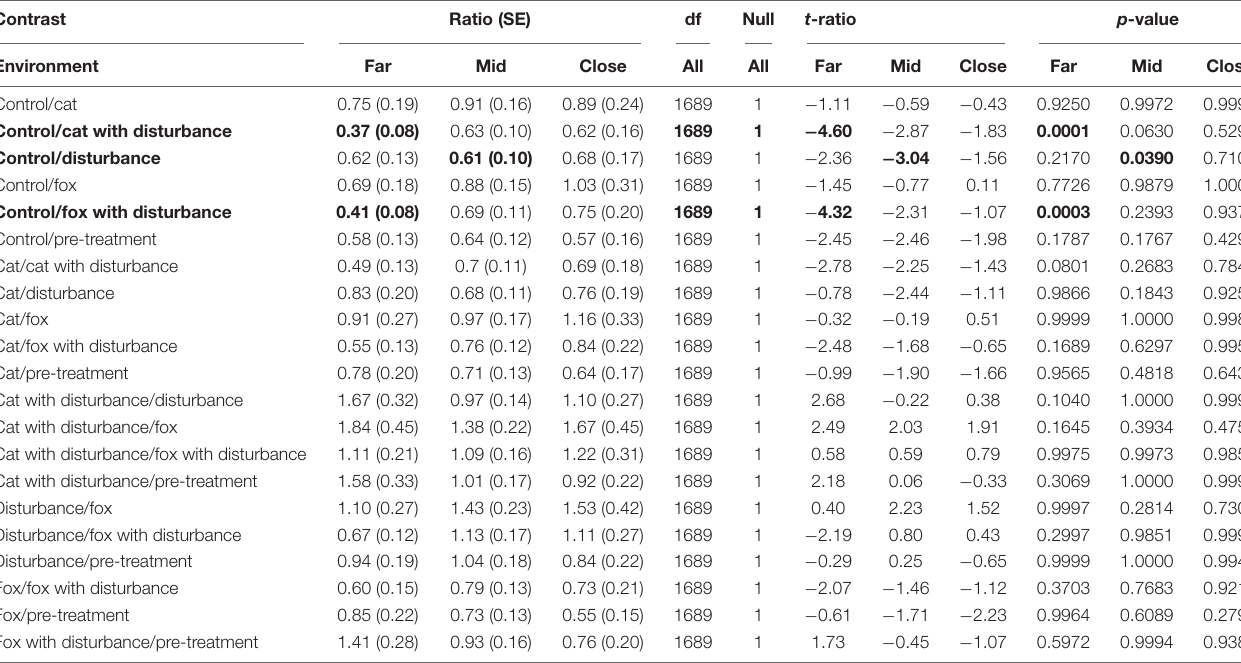
TABLE 2 | Between treatment pairwise contrast ratios for estimated marginal means from generalized linear mixed models with zero inflation and dispersion parameters for giving-up density (GUD) responses, under the explanatory variables of treatment and